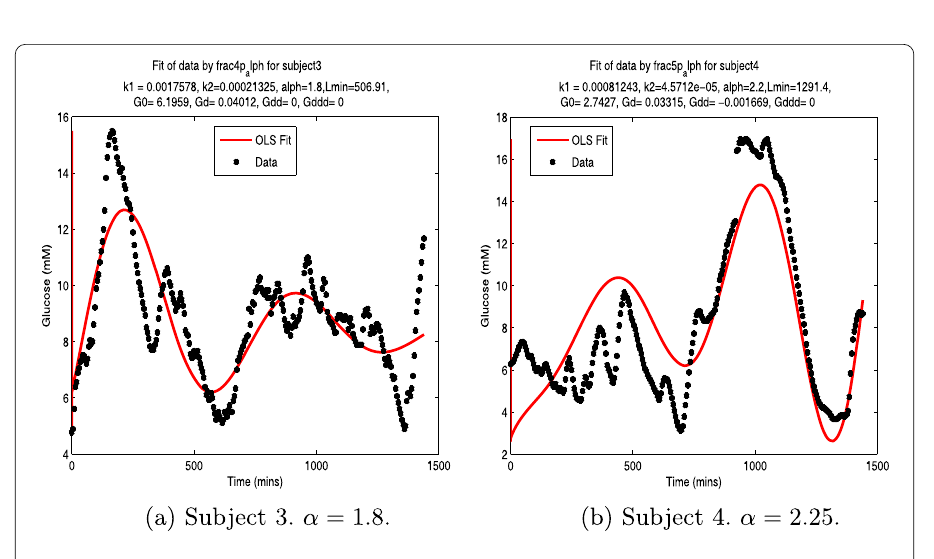
Figure 5 Plot of best fits for subjects 3 and